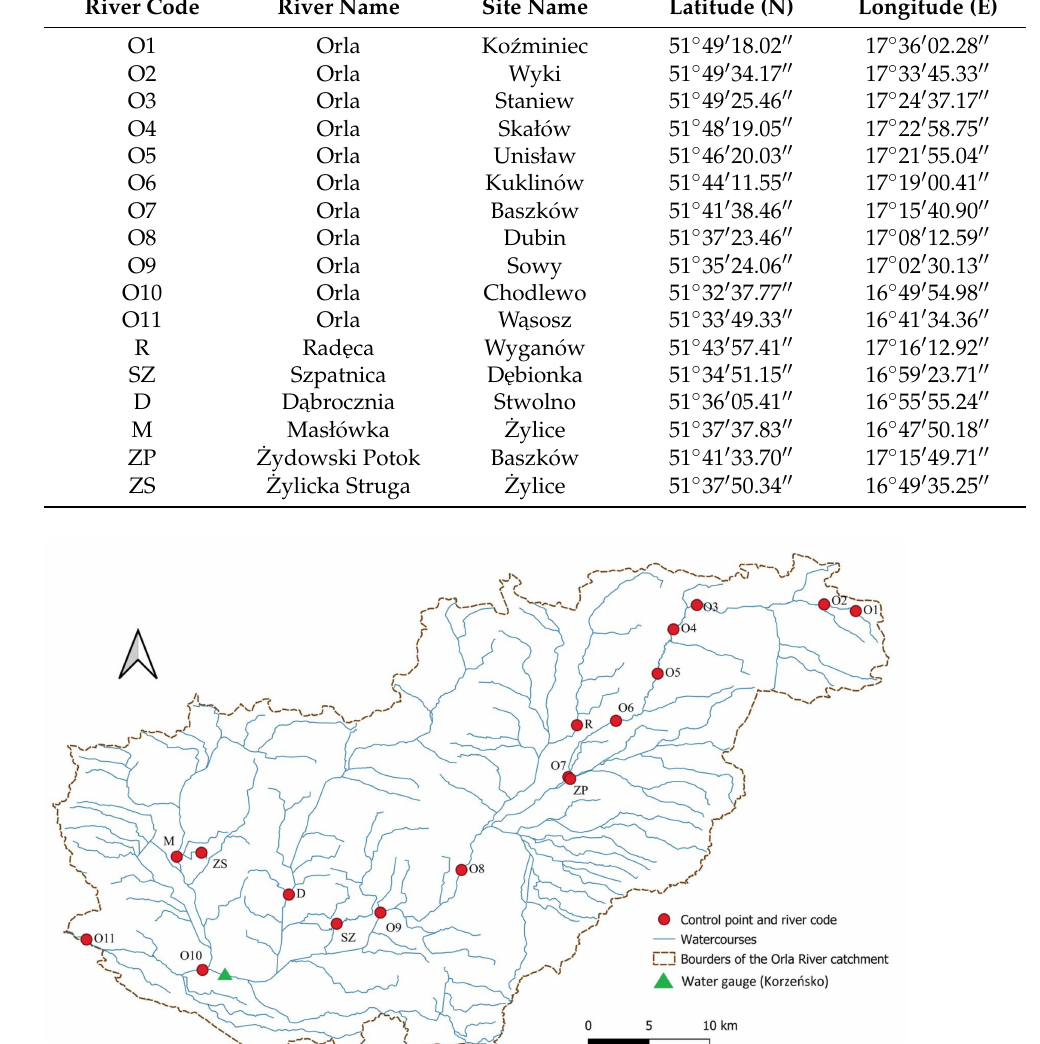
Figure 2. Location of the testing points in the Orla River catchment (site codes in Table 1) O1—Orla (Ko´zminiec), O2—Orla (Wyki), O3—Orla (Staniew), O4—Orla (Skał ó w), O5—Orla (Unisław), O6— Orla (Kuklin ó w), O7—Orla (Baszk ó w), O8—Orla (Dubin), O9—Orla (Sowy), O10—Orla